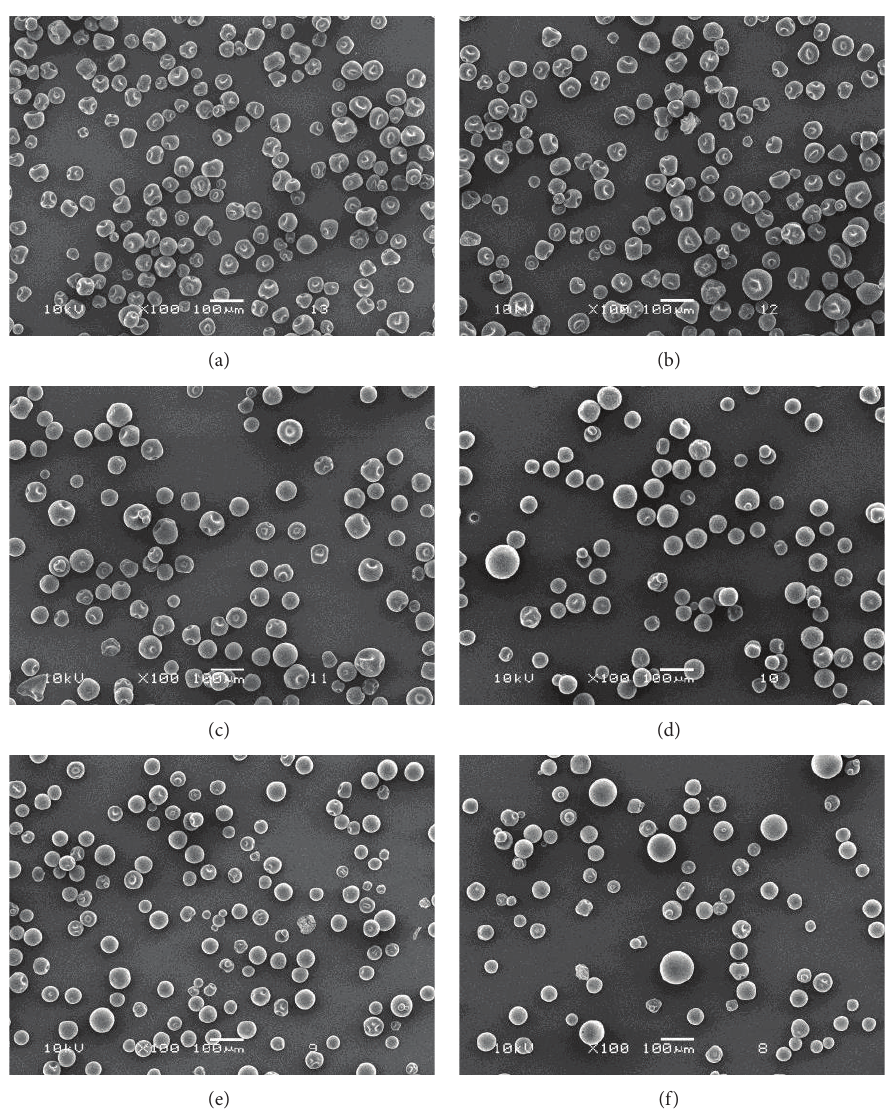
Figure 1: SEM images of drug-loaded gelatin microparticles (a) without crosslinking and crosslinked with (b) 12.5 g glutaraldehyde/100 g gelatin and (c) 25 g glutaraldehyde/100 g gelatin, and drug-loaded blend microparticles with starch/gelatin blend ratios of (d) 20/80, (e) 35/65, and (f) 50/50 (w/w) crosslinked with 25 g glutaraldehyde/100 g starch/gelatin. (All bars = 100 𝜇